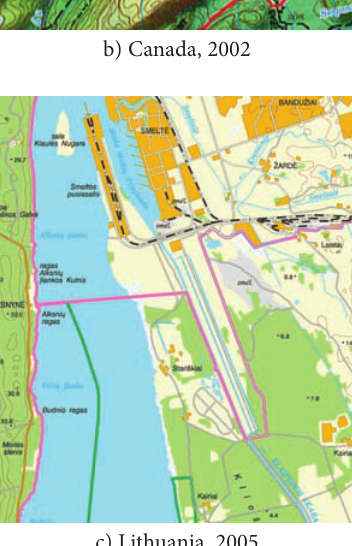
Fig. 2. Fragments of 1:50,000 topographic map